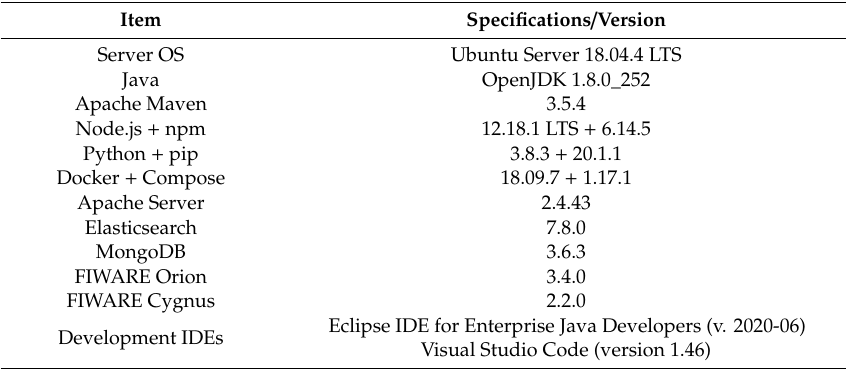
Table 6. In addition, both the software specifications of the pre-built modules (FIWARE components in the Table 7. Table 6. Hardware specifications of the server. Table 7. Software specifications of the